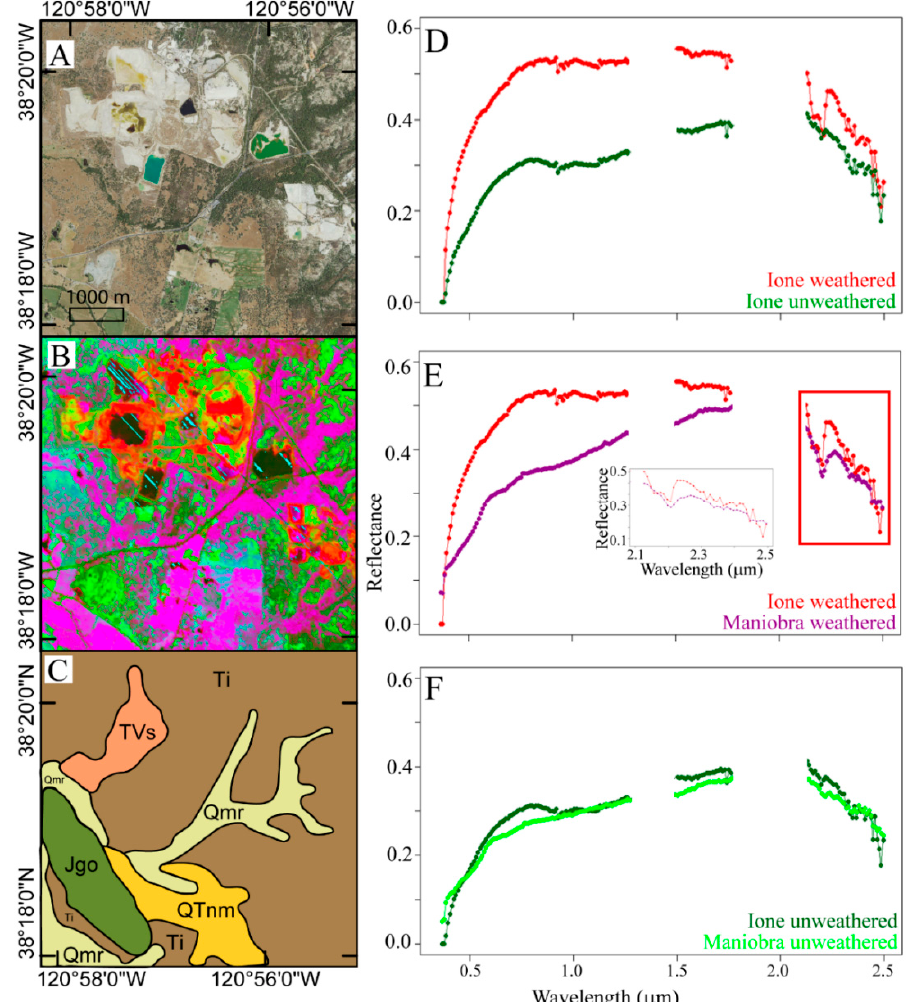
Figure 5. Characterization of the Ione study site. ( A ). NAIP imagery. ( B ). Spectral unmixing result. Red = weathered endmember. Green = unweathered endmember. Blue = other materials. ( C ). Geologic map after [54]. Ti = Tertiary Ione Formation. TVs = Tertiary Valley Springs Formation.